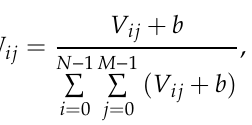
Figure 6. Typical captured images: ( a ) Original glass image captured by the CBF system; ( b ) extracted images by 23 rows and 12 columns from original image in ( a ); ( c ) Original image captured by the LABF system; ( d ) extracted images by 23 rows and 12 columns from original image in ( c ).